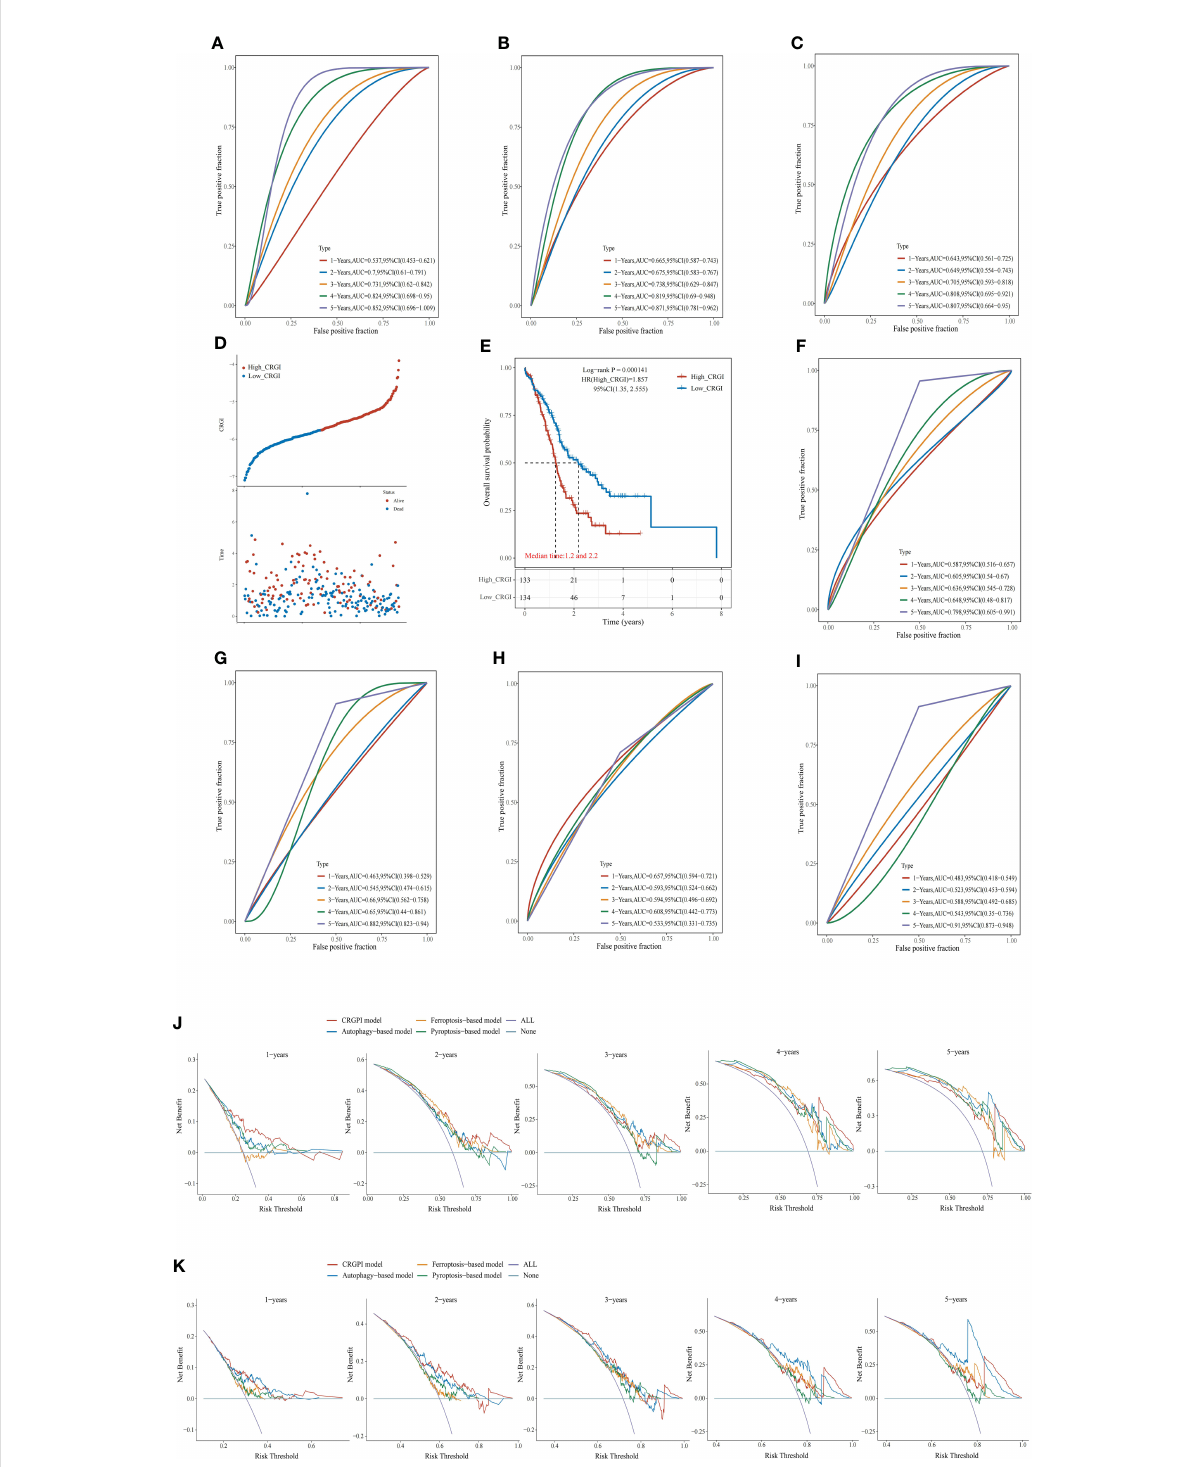
FIGURE 3 Comparison of other cell death mechanisms-based prognostic signatures in PAAD. (A – C) The ROC curve of autophagy-, ferroptosis-, and pyroptosis-based models in the TCGA dataset, respectively. Distribution of the CRGI and survival status of individual PAAD patients (D) , and Survival analysis (E) of the high- and low-CRGI groups in the ICGC dataset. (F – I) The ROC curve of our model, the autophagy-, ferroptosis-, and pyroptosis-based models in the ICGC dataset, respectively. DCA diagrams of our model, the autophagy-, ferroptosis-, and pyroptosis-based models in the TCGA dataset (J) , and ICGC dataset (K) . All: all positive; None: all negative. They are the extreme conditions that serve as background